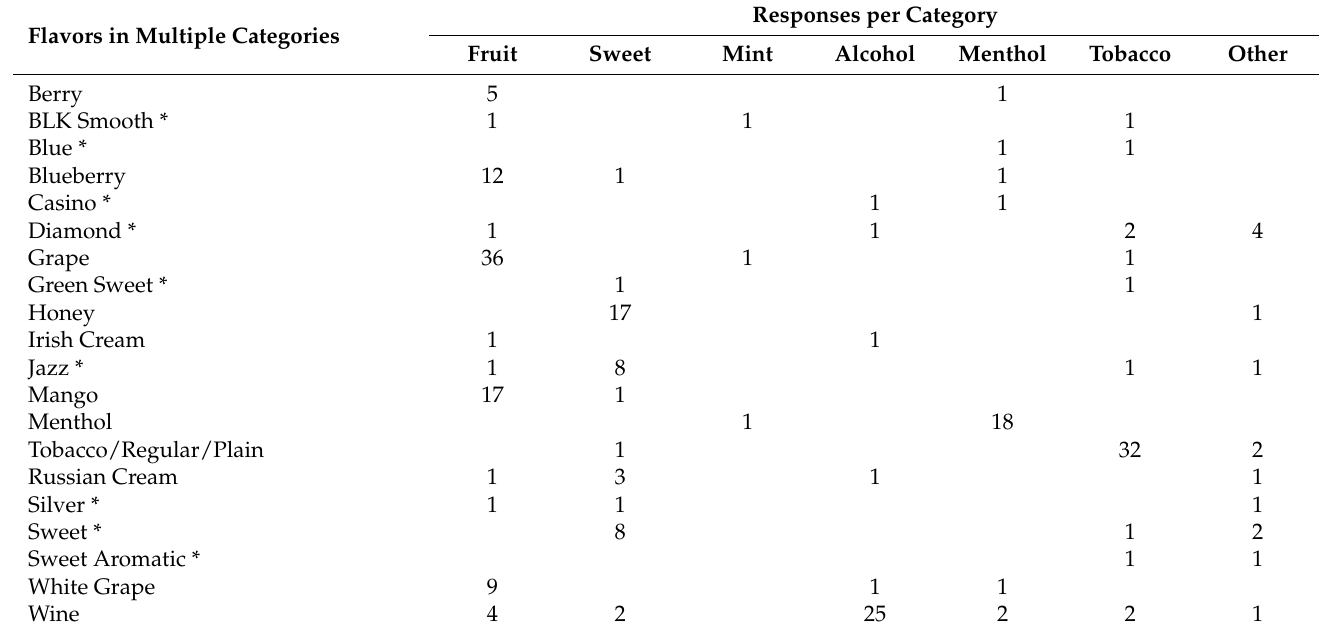
Table 5. Individual cigarillo flavors placed in more than one flavor